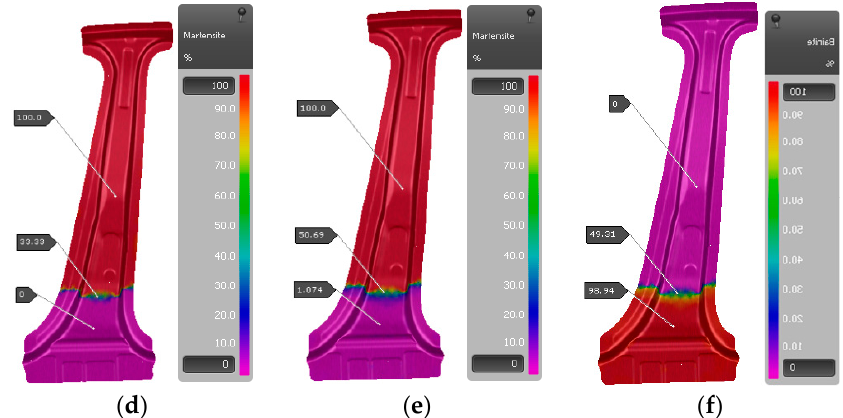
Figure 12. Microstructure distribution at different times: ( a ) before stamping; ( b ) stamping for 4 s; ( c ) austenite distribution after stamping; ( d ) martensite distribution after stamping; ( e ) martensite distribution after being cooled; and ( f ) martensite distribution after being cooled.